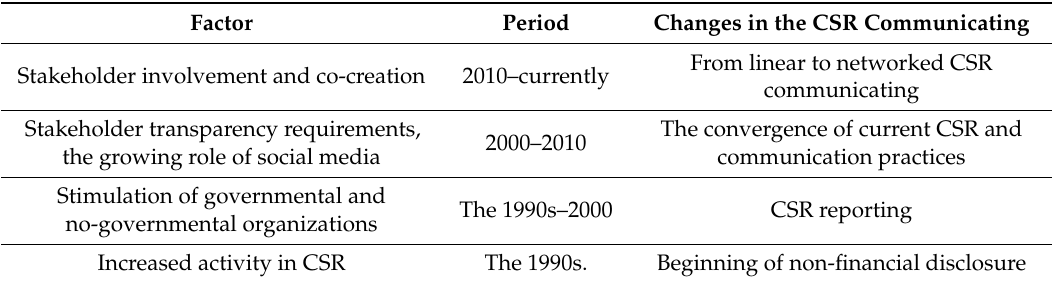
Table 1. External factors determining changes in the approach to communicating Corporate Social Responsibility